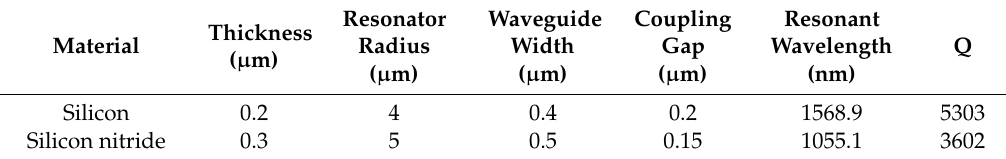
Table 2. The WGM resonator